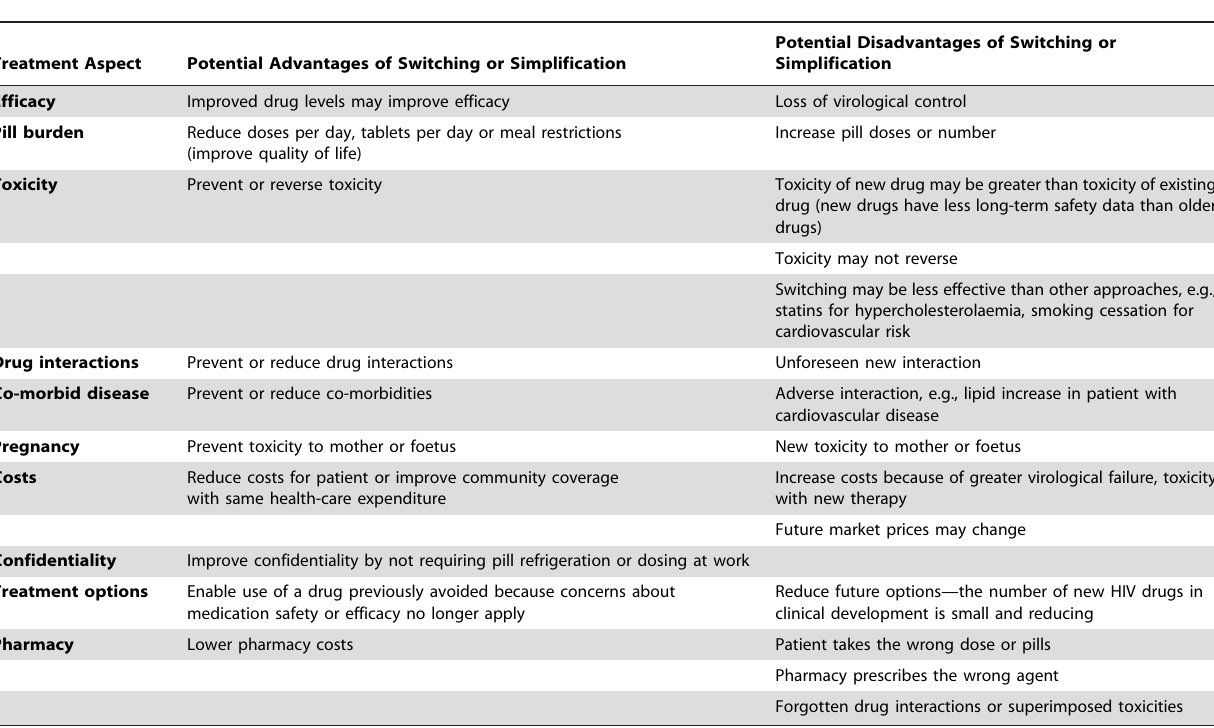
Table 1. Switching and simplifying antiretroviral therapy in a patient with controlled HIV replication.